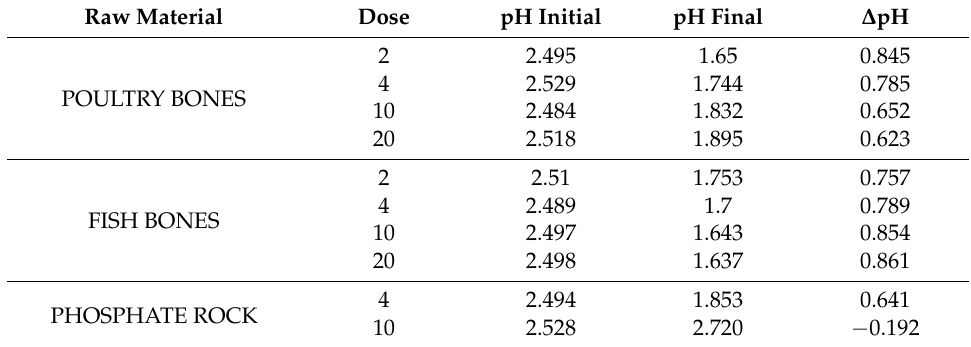
Table 1. The comparison of initial and final as well as ∆ pH recorded for different doses of raw